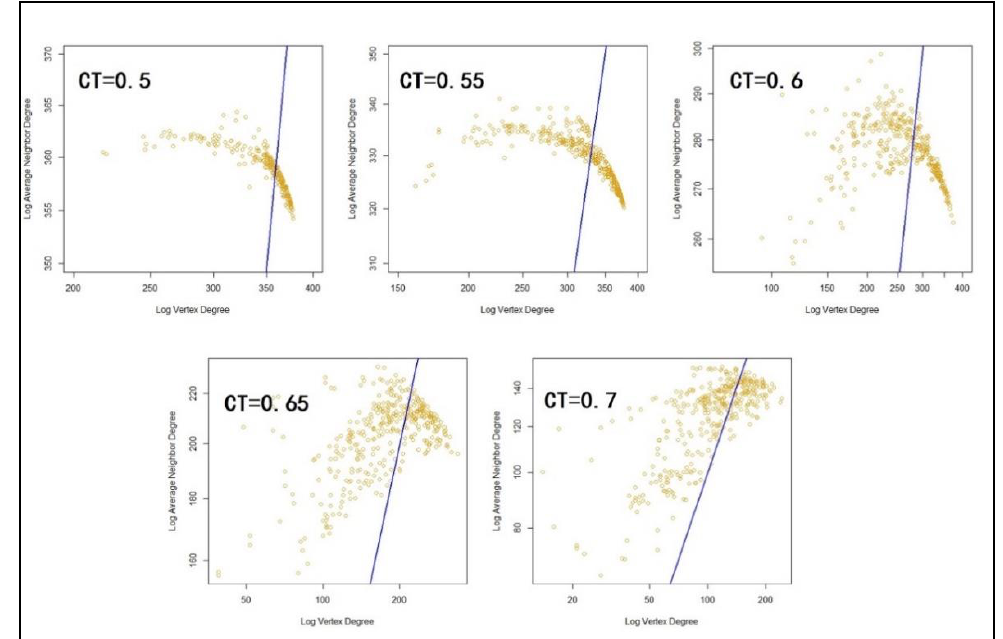
Figure 6. Average neighbor degree versus vertex degree (log–log scale).